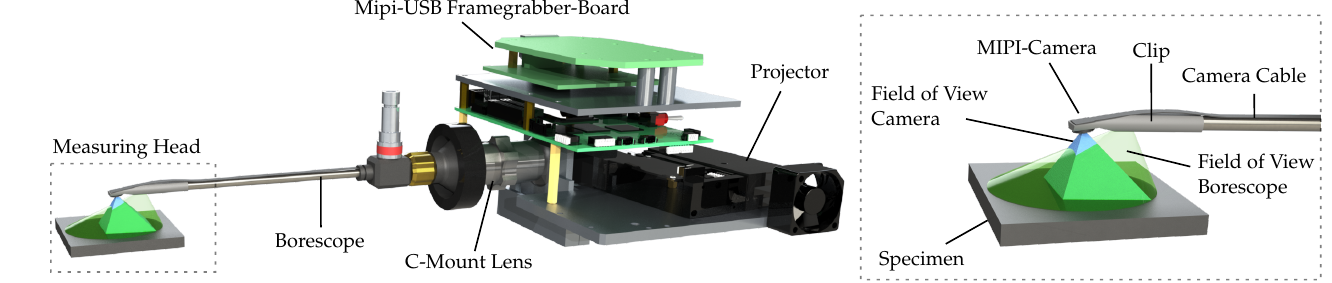
Figure 3. Functional schematic and essential components of a borescopic fringe projection system and a close-up of the measuring head.